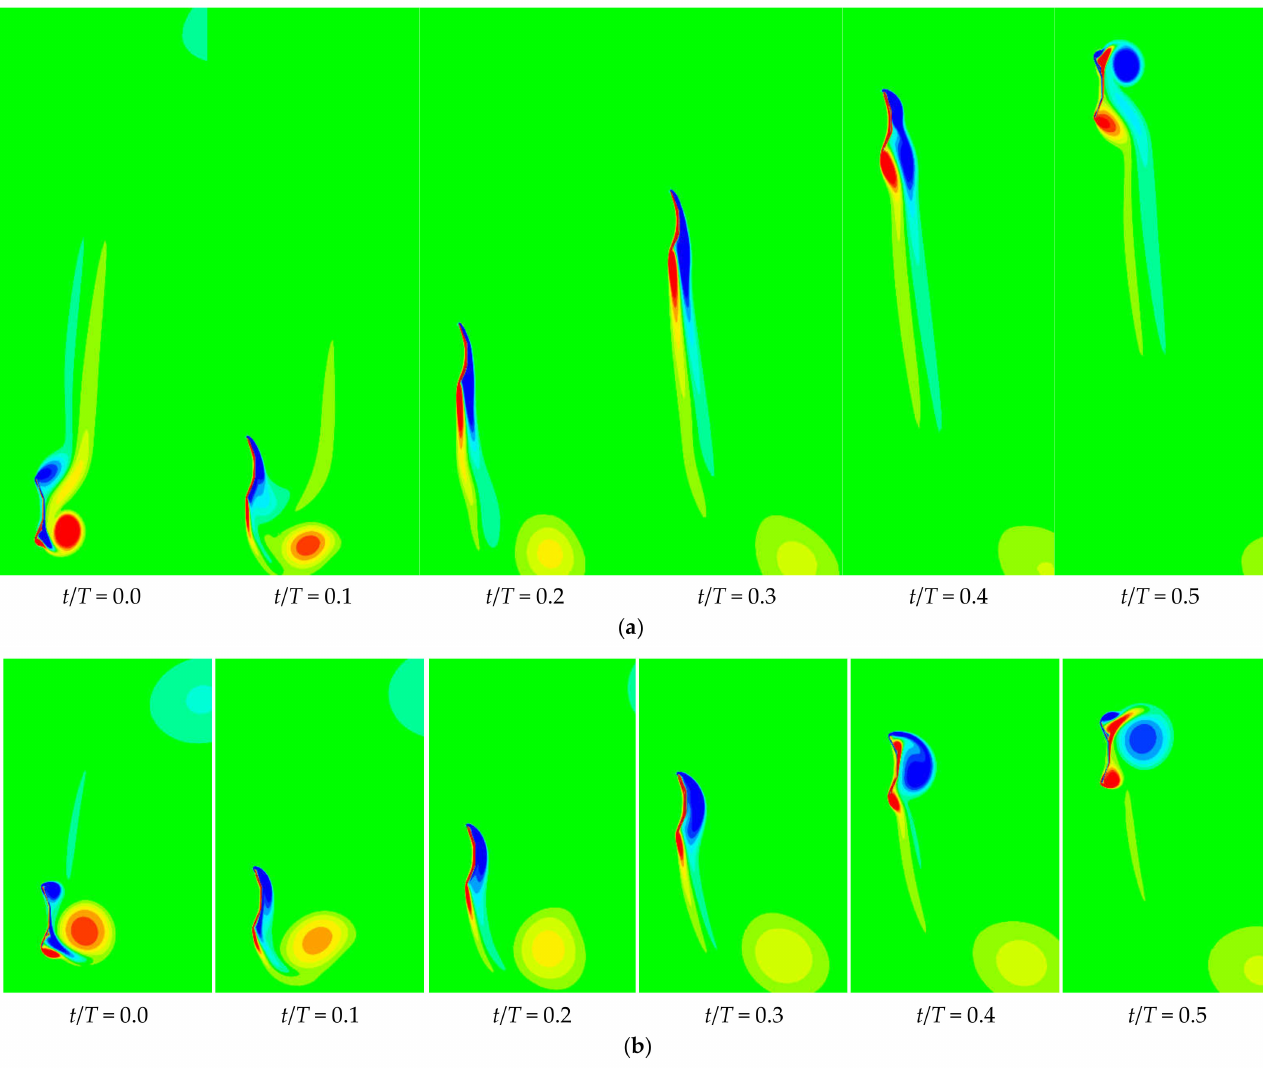
Figure 17. Evolution of the vorticity field in half-cycle for cases of large and small plunging ampli- tudes. ( a ) mass-damping parameter of 0.9, large amplitude. ( b ) mass-damping parameter of 1.0, small